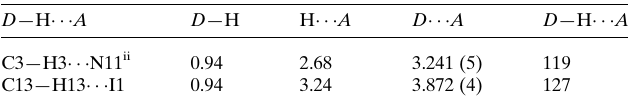
Table 2 Hydrogen-bond geometry (A˚ , (cid:5) ).